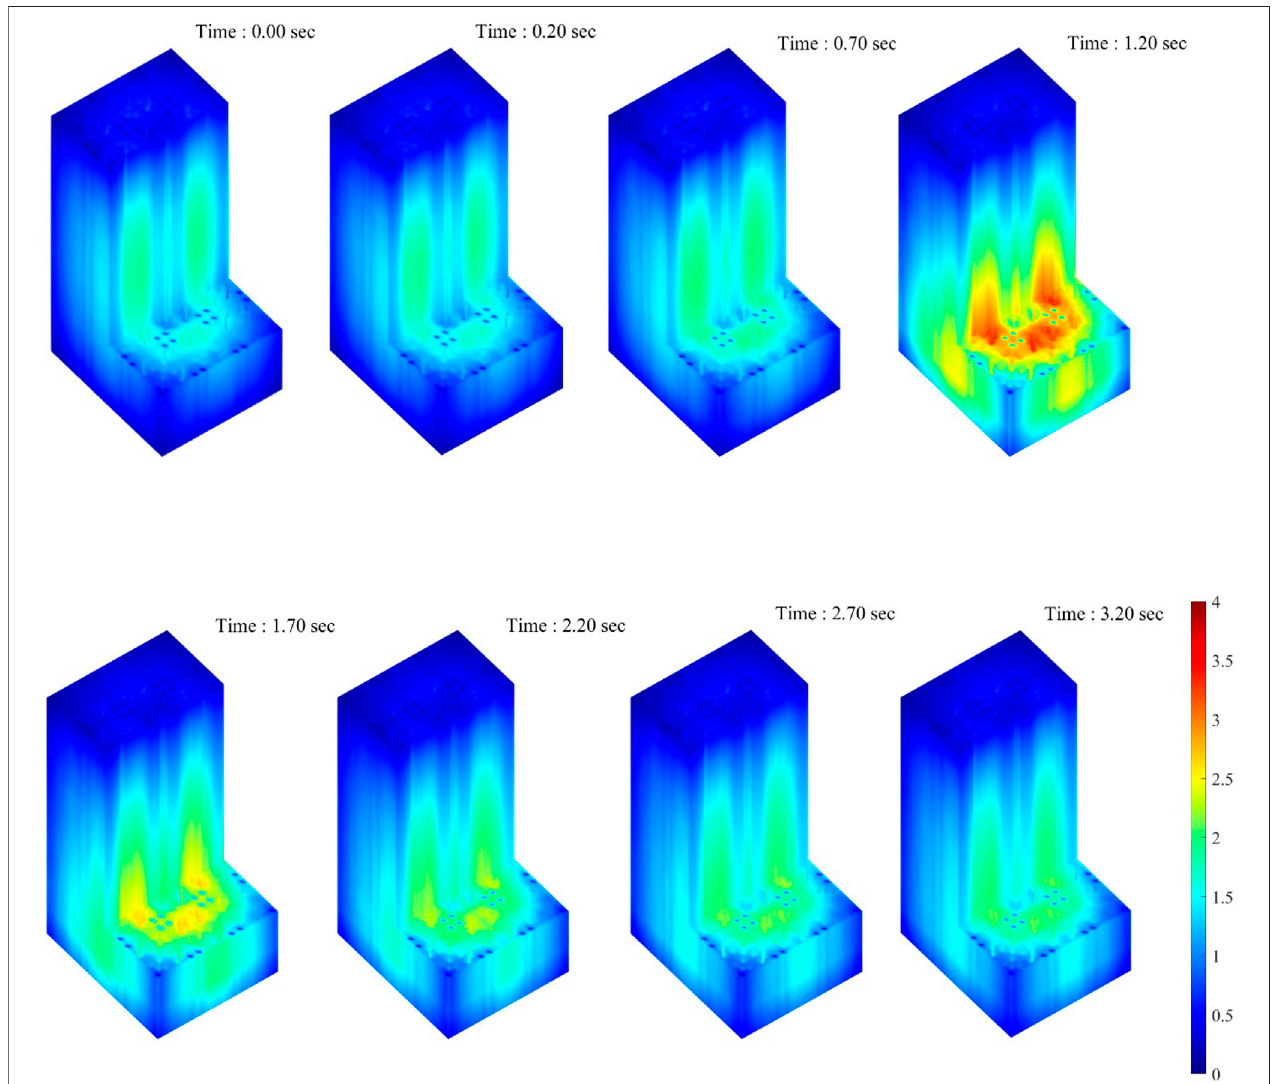
FIGURE 11 | Transient pin-power distribution of the mini-core